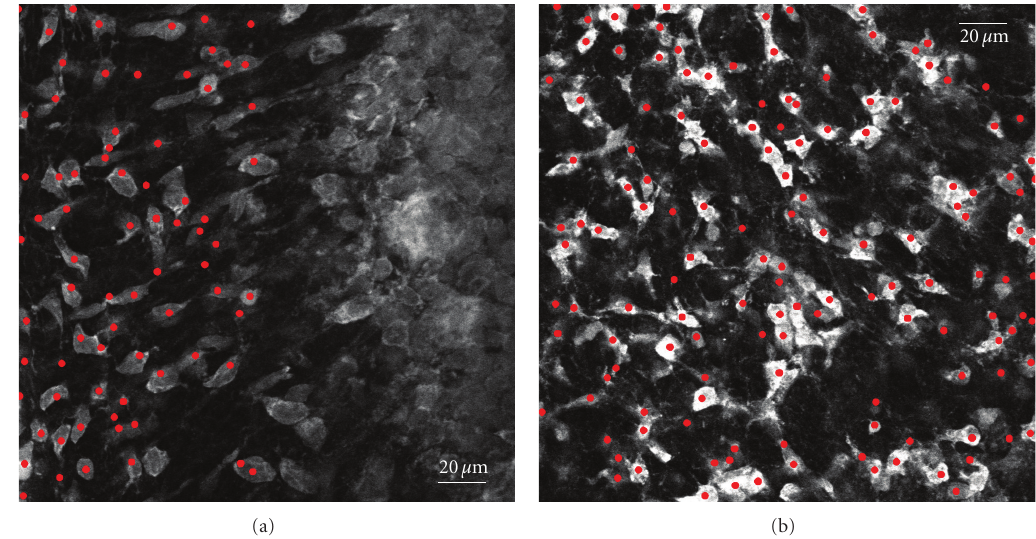
Figure 4: Cerebellum cell counting. (a) A slice of stack 1. (b) A slice of stack 2. Red dots indicate neurons retrieved by the algorithm.